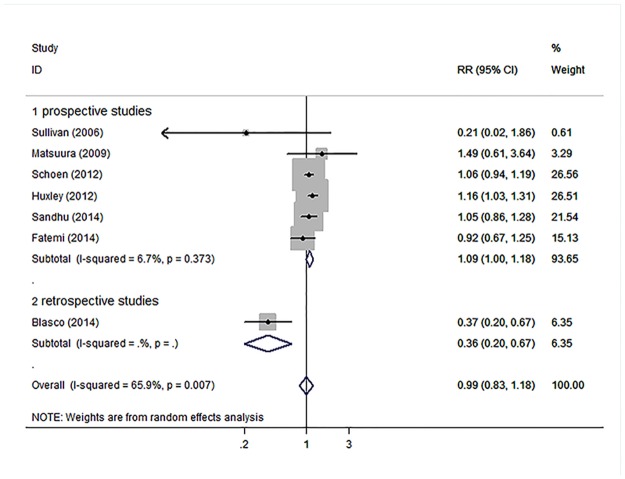
Forest plot demonstrating the association between HbA1c levels and AF depending on different study styles which HbA1c levels were analyzed as categorical variable.Relative risks of AF for higher HbA1c compared with lower HbA1c. Squares indicate study-specific risk estimates (size of the square reflects the study-specific statistical weight, that is, the inverse of the variance); horizontal lines indicate 95% CIs; diamond indicates summary risk estimate with its corresponding 95% CI.